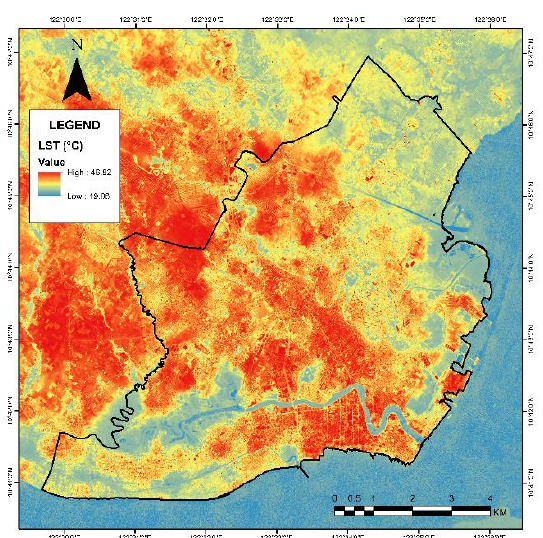
Figure 9. Downscaled LST map of Iloilo City on May 14, 2019 using Regression-Kriging